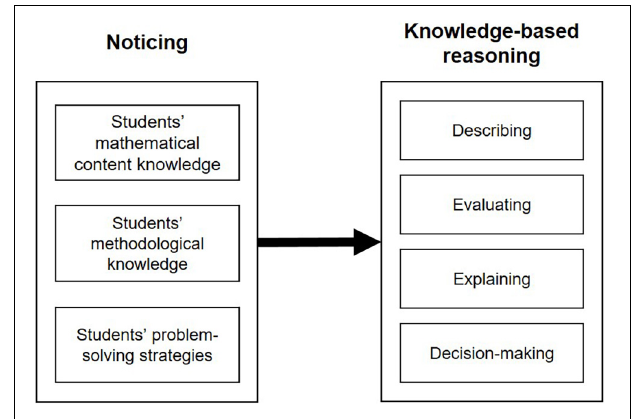
FIGURE 1 | Teachers’ diagnostic activities when assessing students’ mathematical argumentation